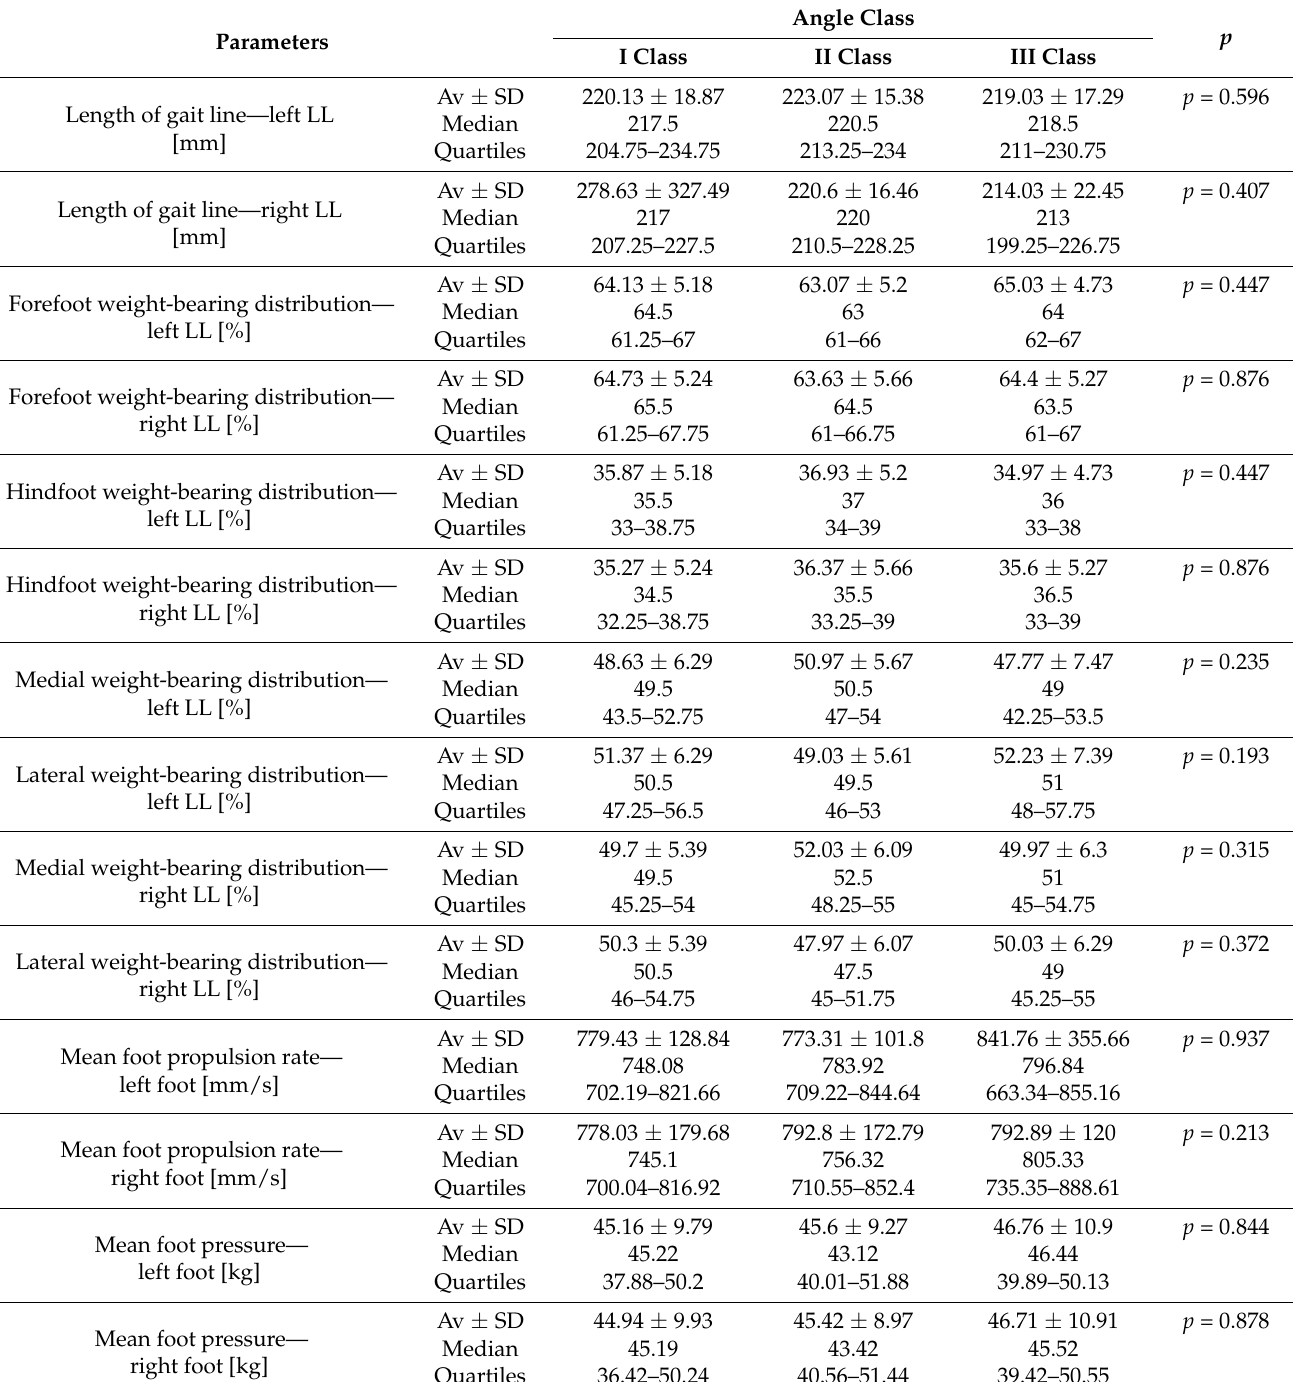
Table 8. Results of selected dynamic test